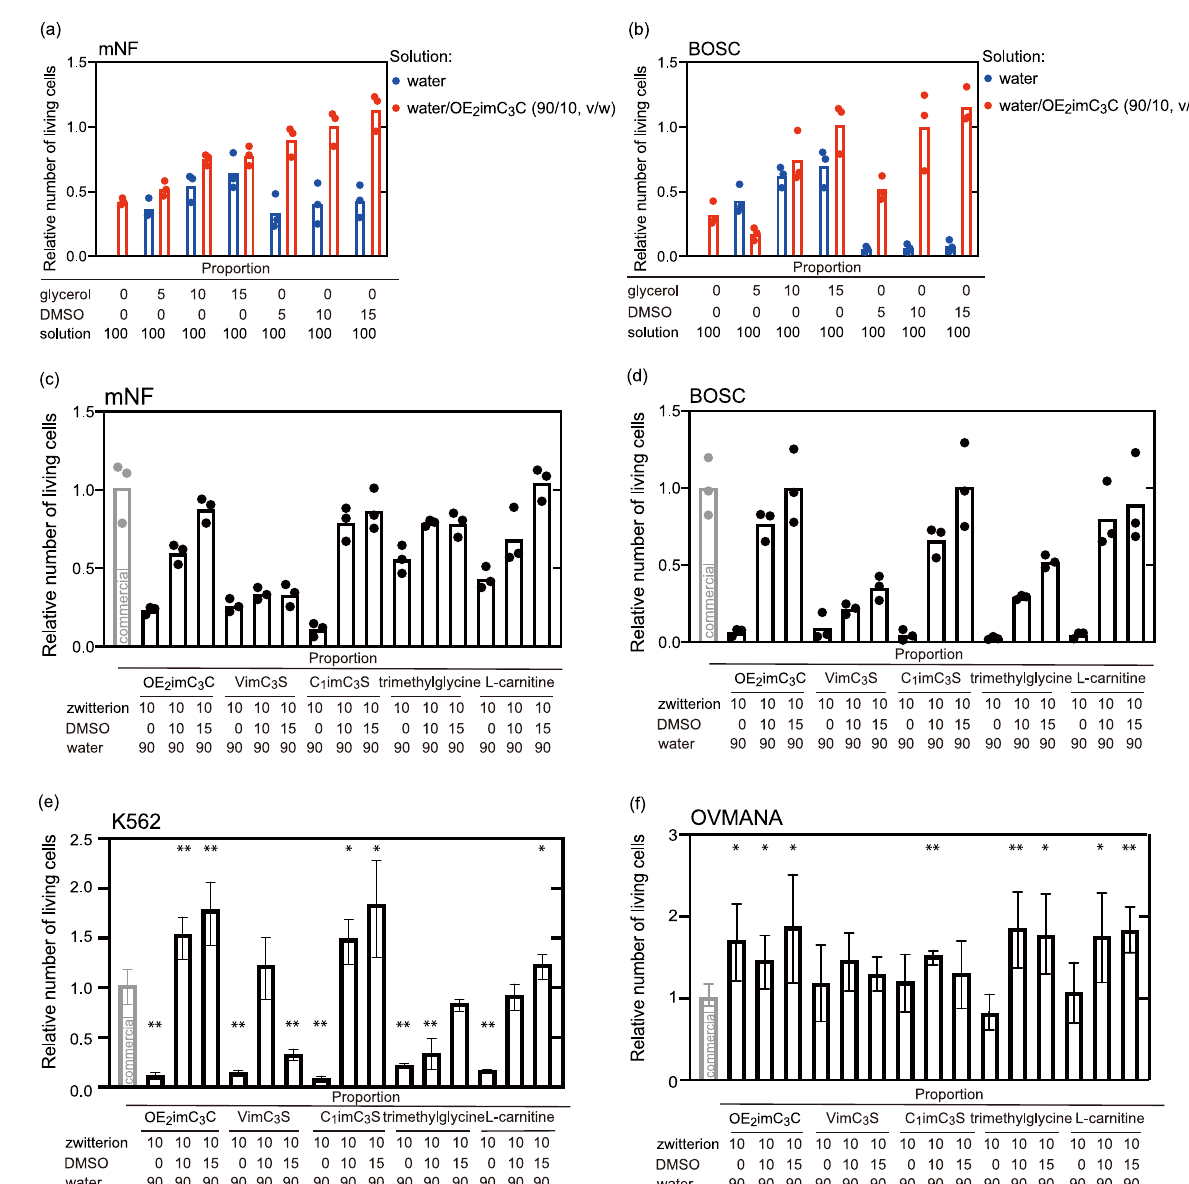
Fig. 5 Cryopreservation of different cells using freezing media containing OE 2 imC 3 C and cell-permeable cryoprotectants. Relative number of living a mNF and b BOSC cells after cryopreservation with mixtures of water/OE 2 imC 3 C (90/10, v/w) and cell-permeable additives (glycerol, DMSO) ( n = 3, experimentally triplicate). A relative number of living c mNF, d BOSC ( n = 3, experimentally triplicate), e K562, and f OVMANA ( n = 3, biologically triplicate) cells after cryopreservation with mixtures of water/zwitterion (90/10, v/w) and DMSO. (* p < 0.1, ** p < 0.05, compared with commercial) The bars show standard error. Total compositions in some cases are over 100 to be clear. The commercial cryoprotectant employed was Culture Sure freezing medium (Fuji fi lm Wako Pure Chemical between DMSO and DPPC lipid molecules, as shown in Figs. S19 and 20. The interaction between OE 2 imC 3 C and lipid molecules (Figs. S21 – S23) can also contribute to shift in surface charge of cell membrane: we found a slight decrease in the DMSO/lipid interaction and no change in the DMSO/water interaction in the presence of OE 2 imC 3 C (Fig. S20, 24). From the discussion, OE 2 imC 3 C interacts with DMSO and lipid and then inhibits the membrane permeation of DMSO, resulting in stabilization of the membrane. This simulation supports one aspect of cryoprotection mechanisms and further study will be required to clarify.